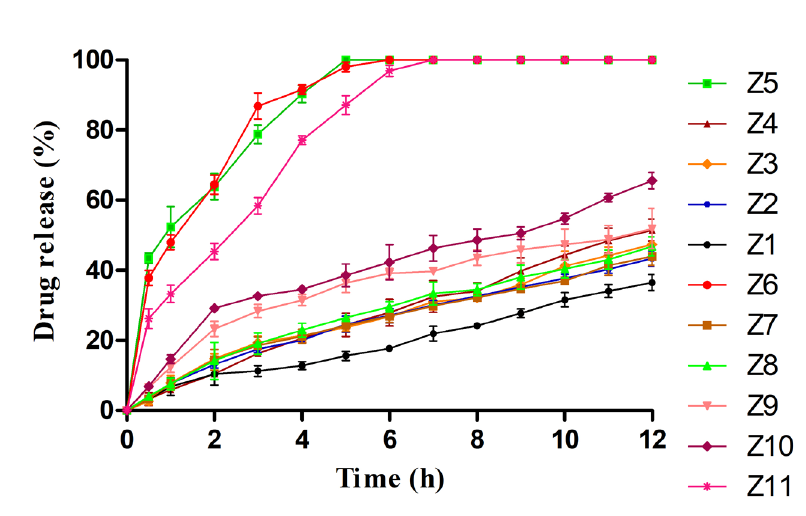
FIGURE 5 - In vitro dissolution profiles of Z1, Z2, Z3, Z4, Z5, Z6, Z7, Z7, Z8 Z9, Z10 and Z11 (n=3). Table IV. K inetic modeling of release data (Z1-Z11)